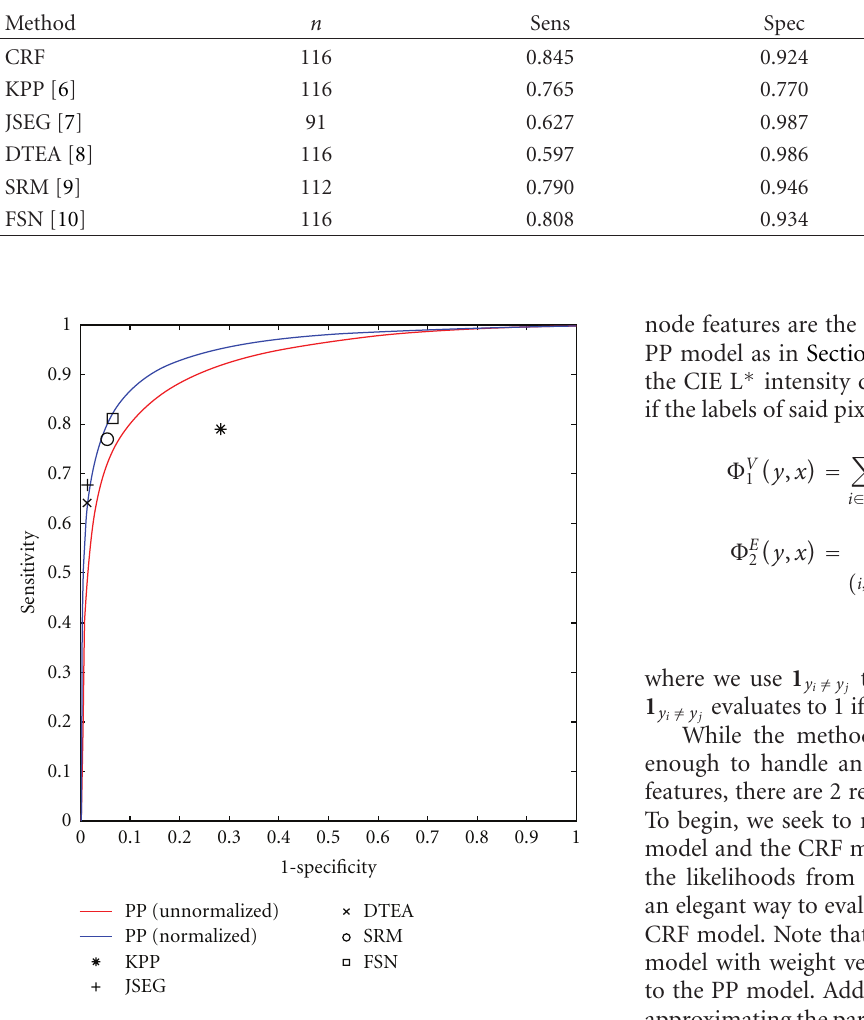
Figure 7: ROC curve comparing our PP model before normaliza- tion (red line) and after normalization (blue line) to 5 previously published